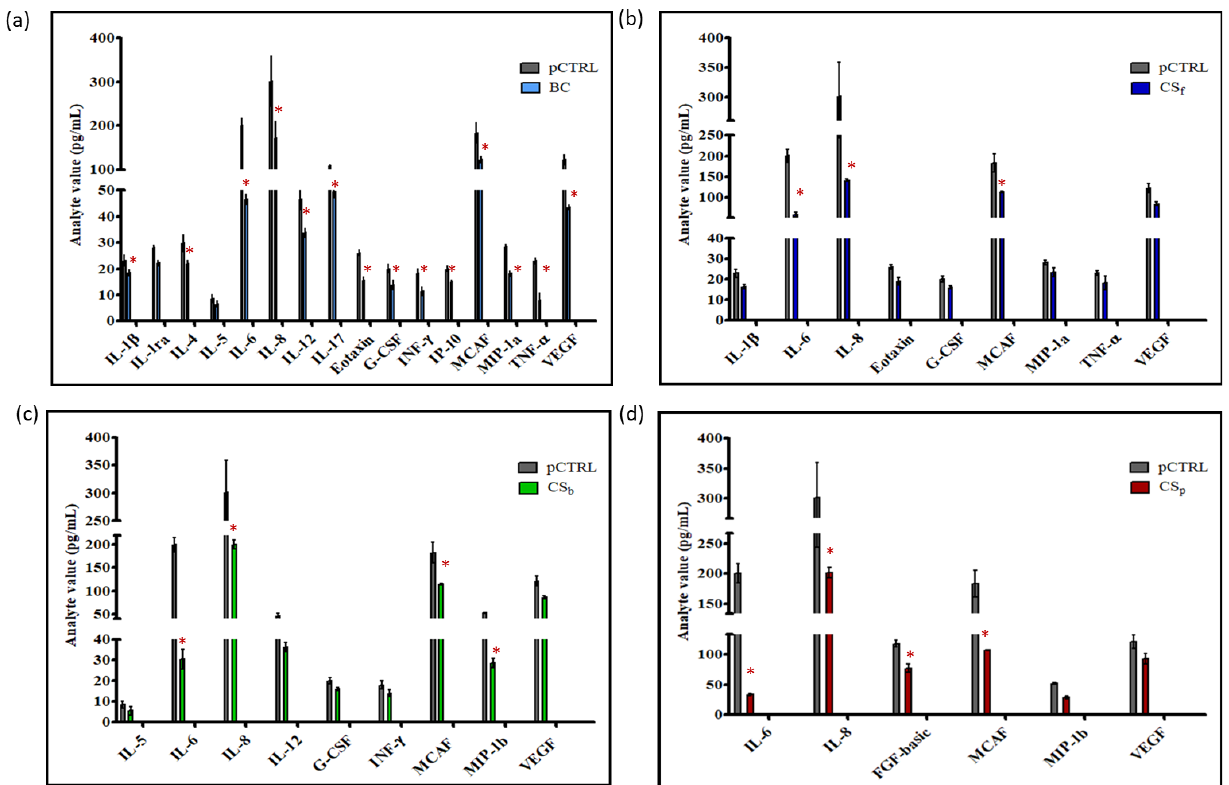
Figure 2. Multiplex assay. Only the analytes with a 0.8 ≥ fold change ≥ 1.2 (vs . pCTRL) were considered differentially modulated. * p < 0.05 vs pCTRL. Data were divided as following: ( a ) pCTRL and BC, ( b ) pCTRL and CS f , ( c ) pCTRL and CS b , ( d ) pCTRL and CS p . pCTRL is the same for all the graphs.